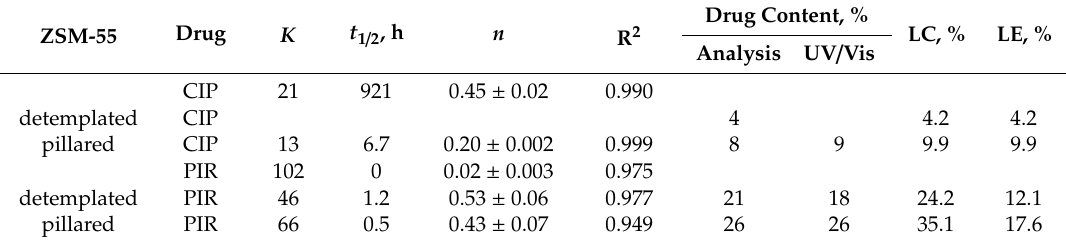
Table2. Exponentofrelease n , kineticconstant K andhalf-timeofrelease t 1 / 2 forfittedKorsmeyer-Peppas release curves (Equation (3)) and coe ffi cient of determination R 2 for the double-logarithmic fitting presented in Figure 4. Drug content determined by elemental analysis and UV / Vis experiments of total release of the drug from the composites (see Section 3 for details). Loading capacity (LC) and loading e ffi ciency (LE%) were calculated using formulas presented in Section 3 (Equations (1) and